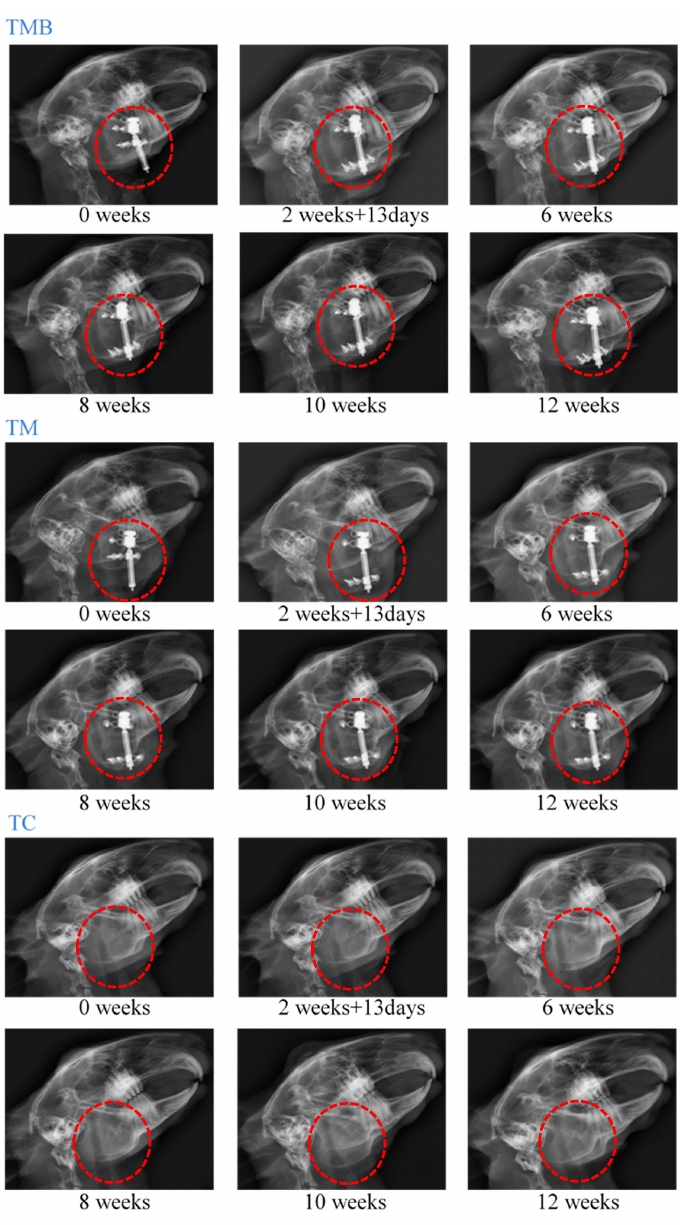
Figure 7. The digital radiography results show that the osteotomy areas at the mandible angulus healed and the bone growth was completed 4 weeks after surgery for all rabbits using multi-axial alveolar bone